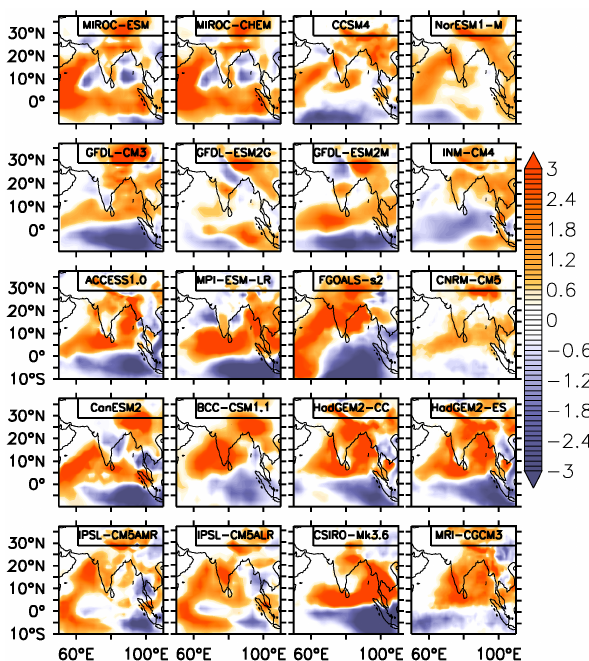
Fig. 9. JJAS rainfall composite difference (mmday − 1 ) for the pe- riod 2070–2100 under RCP-8.5 scenario and for the period 1970– 2000. The majority of the models capture an increase in summer monsoon mean rainfall by about 0–3mmday − 1 in most parts of India.